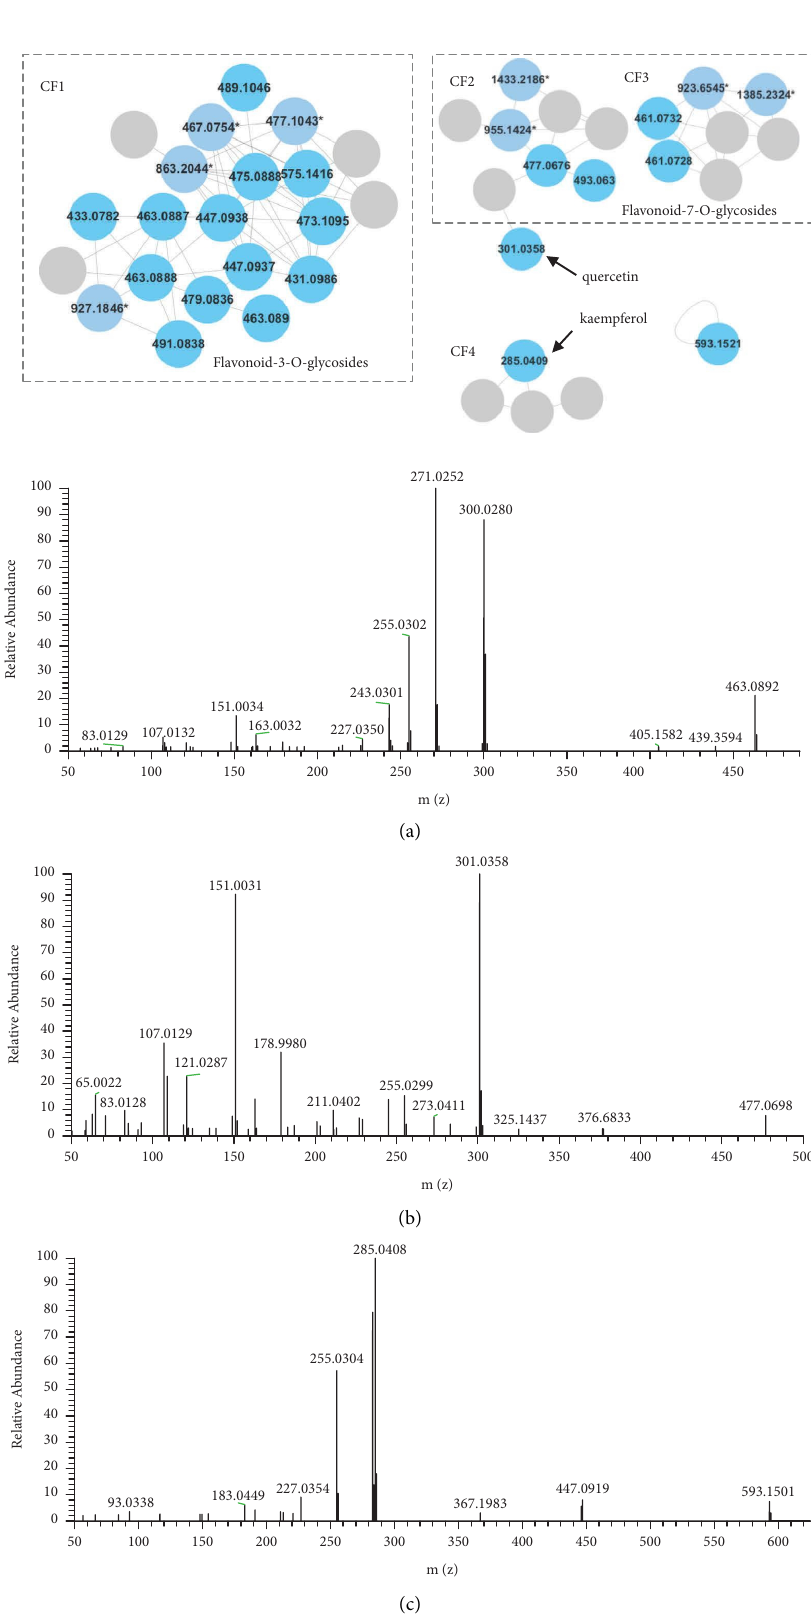
Figure 5: Molecular network of favonoids from LCP and MS 2 spectra of isoquercitrin (a), quercetin-7-O-glucuronide (b), and kaempferol- 7-O-glucoside-O-rhamnoside (c). Flavonoid-3-O-glycosides were mainly included in cluster CF1, while favonoid-7-O-glycosides were clustered in CF2 and CF3. Te nodes flled with bright blue and grey blue represent [M − H] − and adduct ions of compounds, respectively. Te chemical structure nodes flled with grey colour are not annotated in present